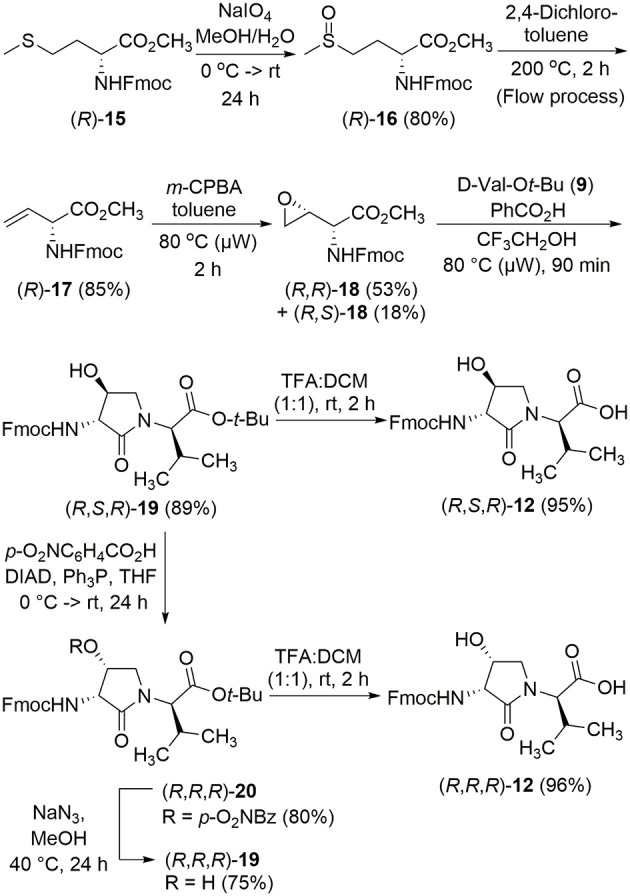
Synthesis of β-hydroxy-α-amino-γ-lactams (Hgl) dipeptides using N-(Fmoc)oxiranylglycine.